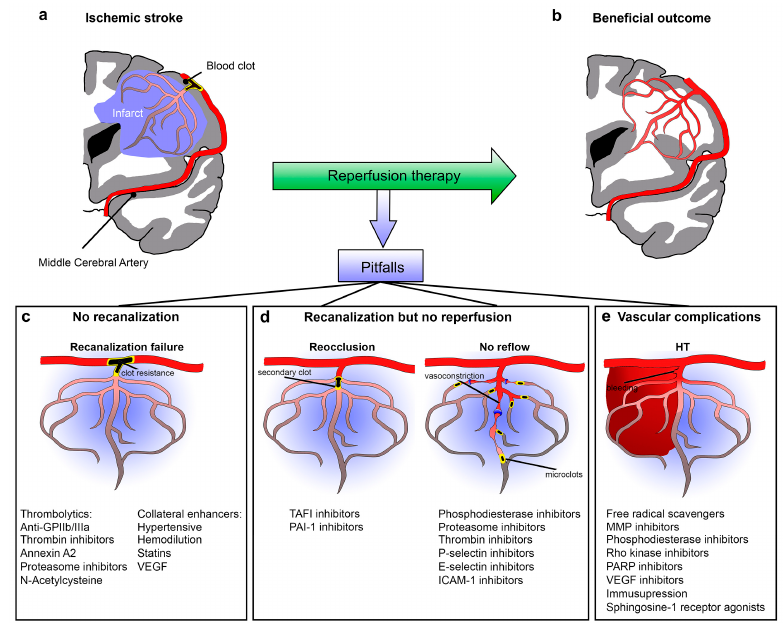
Figure 1. Vascular challenges for reperfusion therapy. ( a ) Schematic diagram of a coronal section of the brain. The middle cerebral artery (MCA) is occluded with a blood clot. The blue areas correspond to the infarct that could be saved with reperfusion therapy ( b ). The different possible pitfalls of reperfusion are shown as no recanalization ( c ), recanalization but no reperfusion and arterial reocclusion and no-reflow ( d ), and vascular complications: hemorrhagic transformation ( e ). In c – e , a summary of potential molecules involved in blood flow regulation is given for each scenario. Abbreviations: GPIIb/IIIa, glycoprotein IIb/IIIa receptors; VEGF, Vascular Endothelial Growth Factor; TAFI,